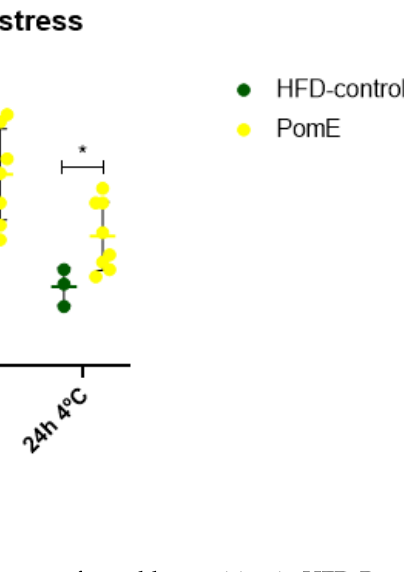
Figure 5. Mice rectal temperature after cold exposition in HFD-PomE (N = 4–6) and HFD groups (N = 4–6). Statistically significant values are indicated with asterisks based on their p- value, * p < 0.05.